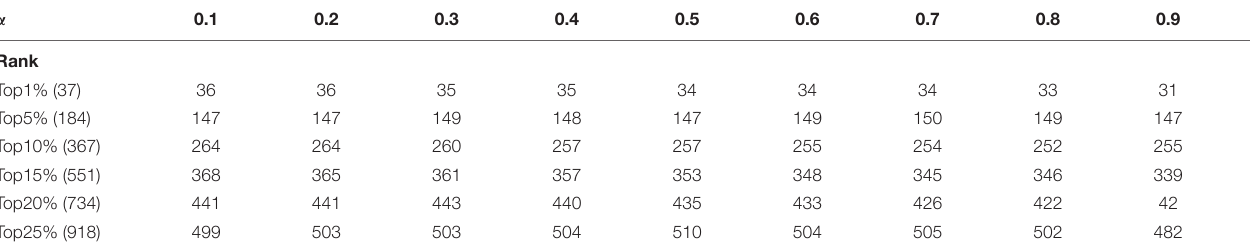
TABLE 7 | Influence of the parameter α on the prediction accuracy of KFPM based on the Krogan